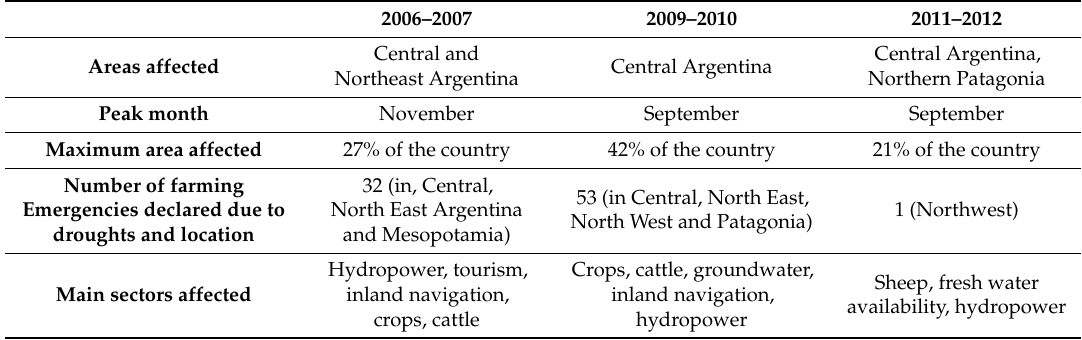
Table 1. Main drought characteristics and impacts of the 2006, 2009, and 2011 droughts in Argentina. Sources detailed in Tables 2, A1 and A2.